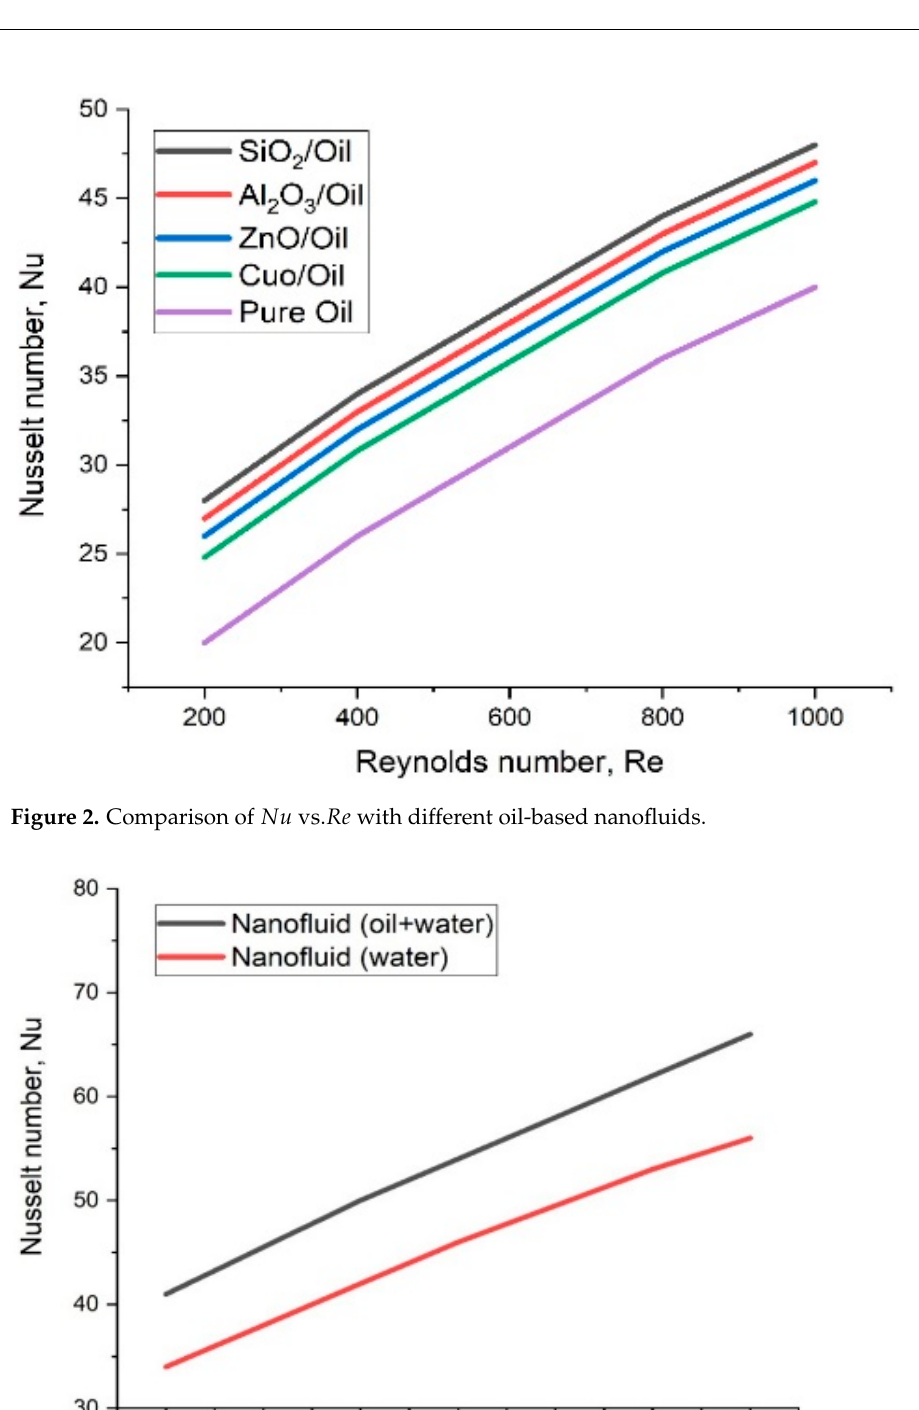
Figure 4. Comparison of 𝑁𝑢 vs. 𝑅𝑒 with simple and hybrid nanofluids. It is evident from the comparative study, as shown in Figure 3, that the oil-based nanofluids deliver added thermal conductivity as compared to the base fluid. The nano particles concentrations is also a major parameters that can affect the thermal conductivity of nanofuids, as shown in Figure 5. The literature review also revealed that the thermal conductivity of hybrid Ag − WO (cid:2871) /mineral-oil-based nanofluids is higher than the amine- treated graphene mineral-oil-based and simple MWCNT/mineral-oil-based fluid, as shown in Figure 6. Figure 7 shows that the thermal conductivity of Al (cid:2870) O (cid:2871) − MWCNT /ther- mal-oil-based nanofluids is higher than MgO − MWCNT /thermal oil and simple